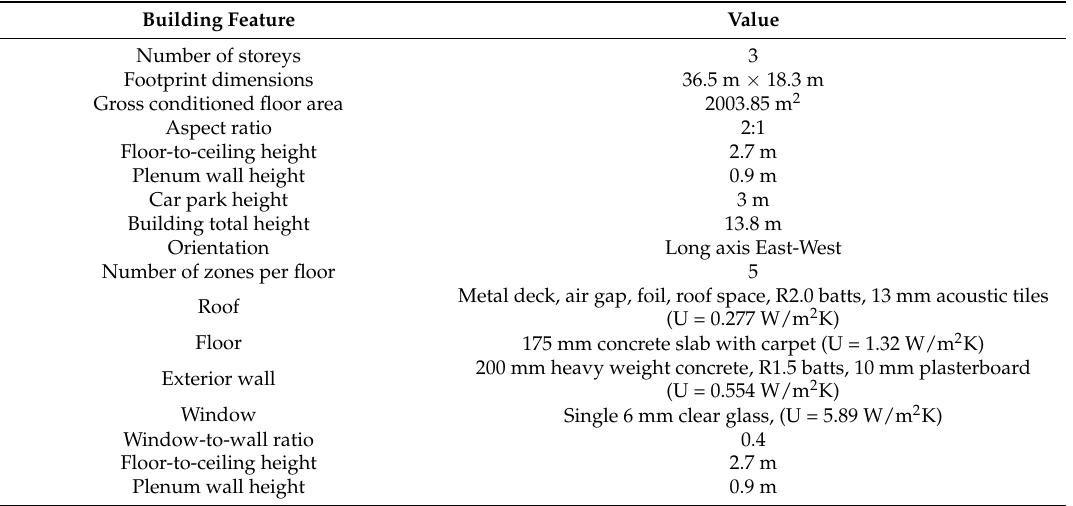
Table 1. Building model physical properties [16].